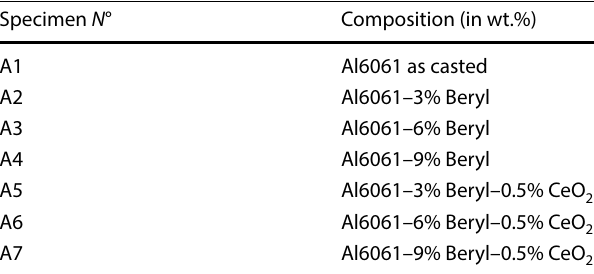
Table 2 Batch compositions of processed Al MMC’s Specimen N